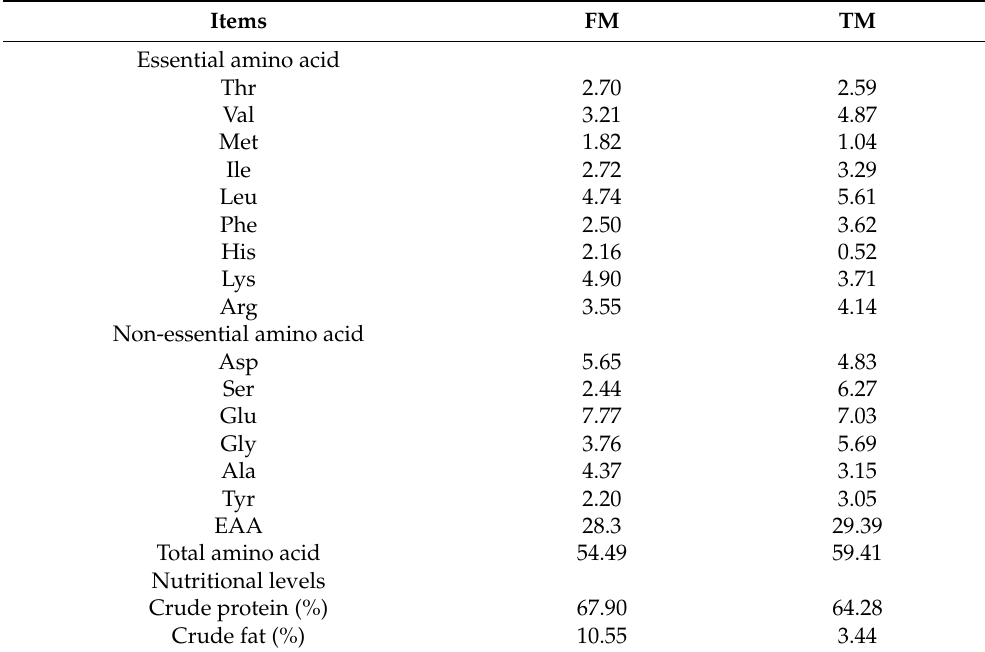
Table 1. Amino acid composition and nutrient levels of FM and TM.